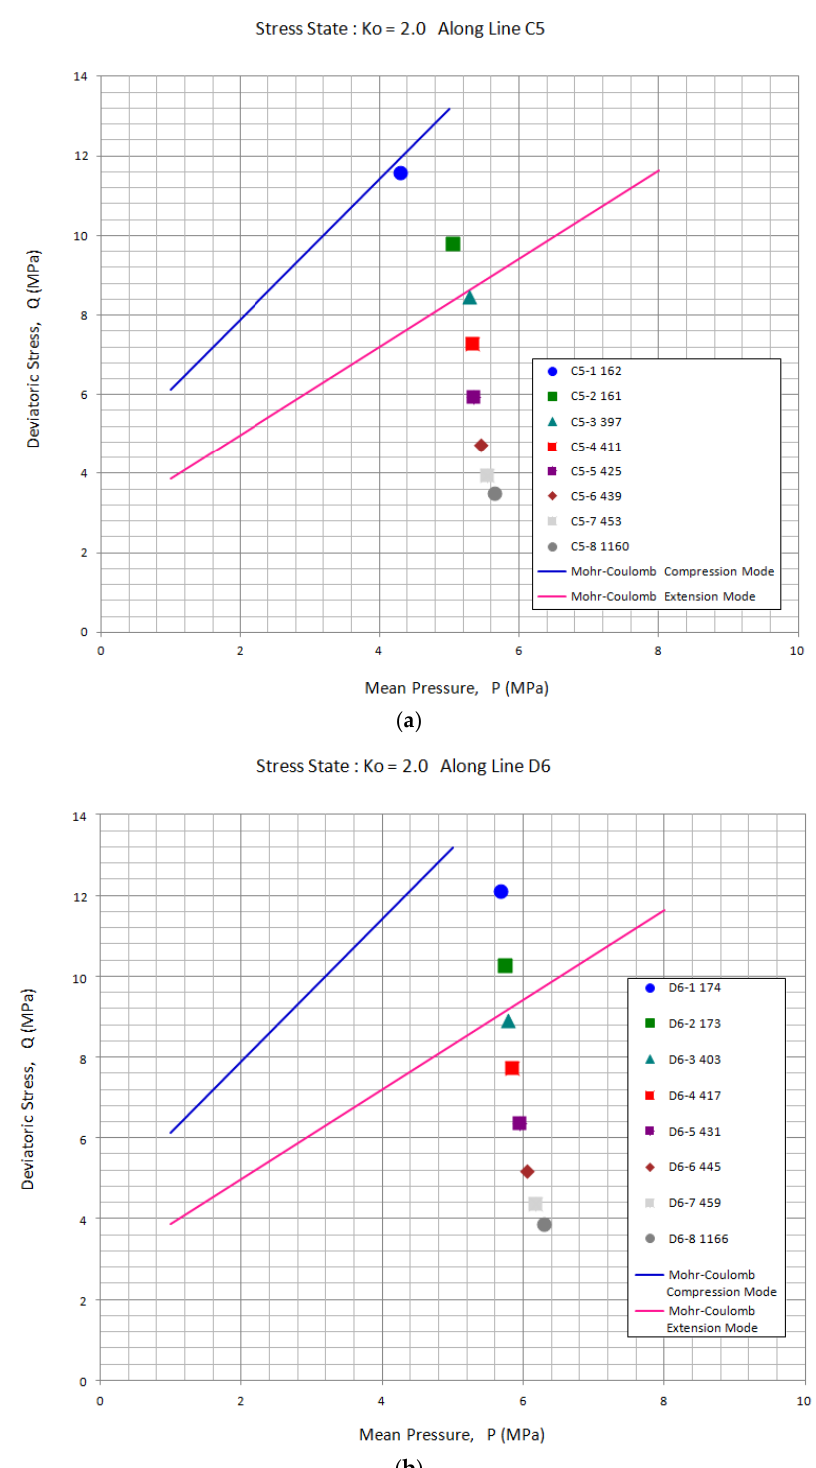
Figure 14 . Stress state (Ko = 2.0): ( a ) Line C5; (b) Line D6. Figure 14. Stress state (Ko = 2.0): ( a ) Line C5; (b) Line